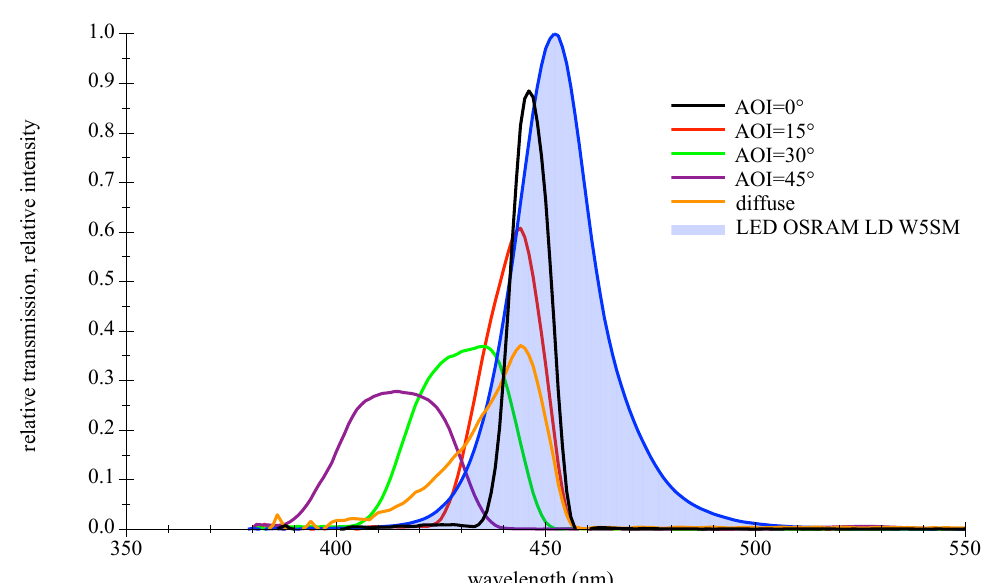
Figure 10. Measured spectral transmission curves for a thin film bandpass filter Thorlabs FBH450-10 with a directed light source at different AOIs and with a diffuse light source. The measured relative intensity distribution of a deep blue LED OSRAM LD W5SM is also given as filled curve to illustrate the overlap. For further information please refer to the appendix in Appendix A.3.